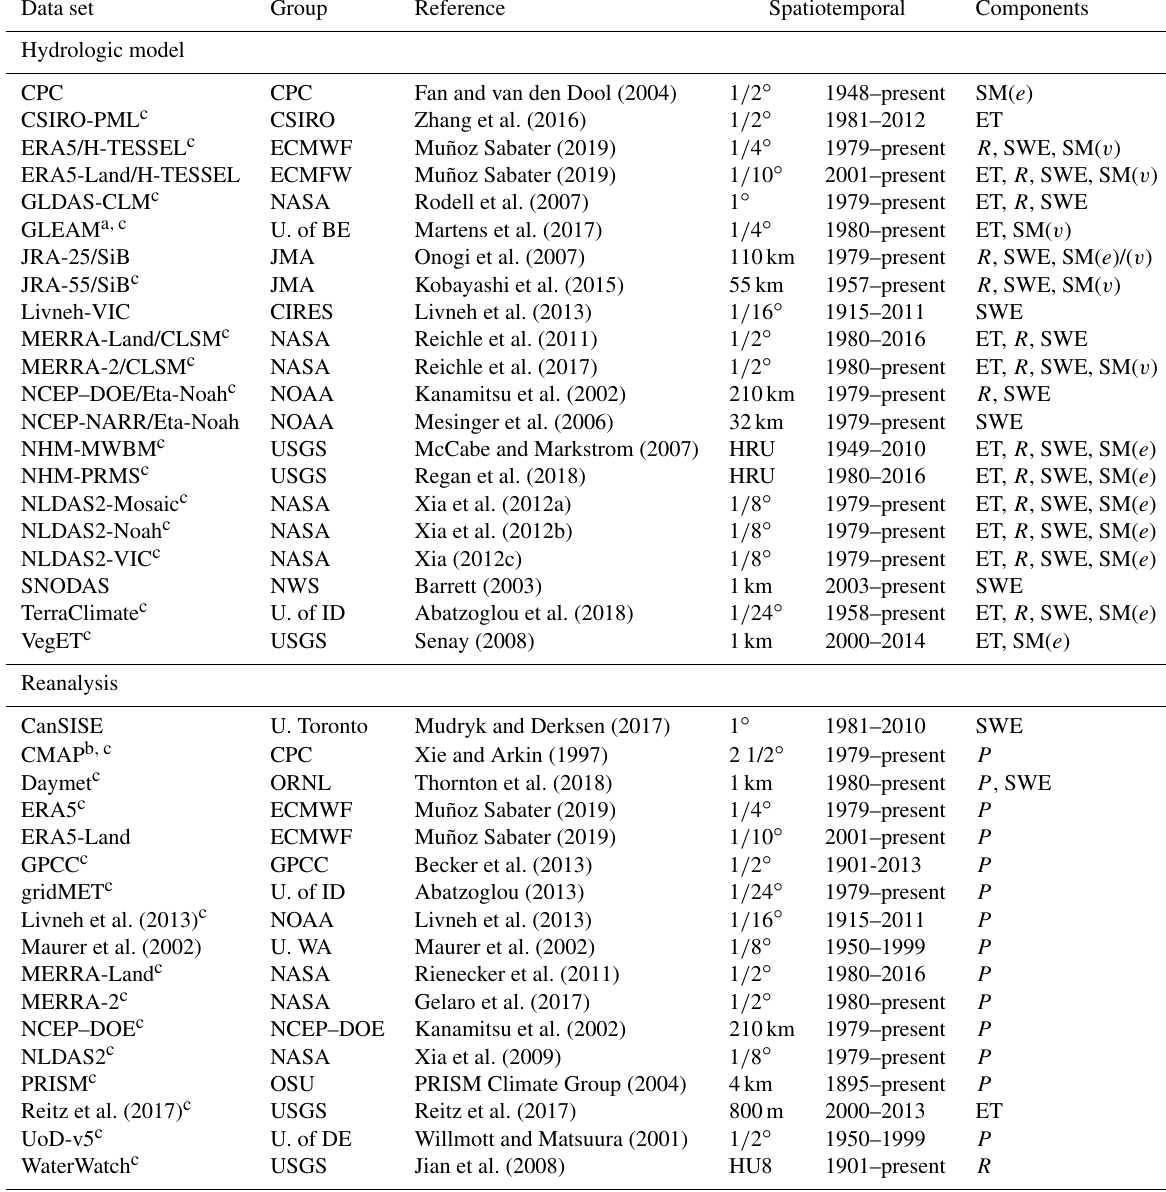
Table 1. Summary of data sets used in this research, including assigned data category, abbreviated name, primary organization, literature reference, spatiotemporal resolution, and sourced hydrologic components. The reader is referred to Appendix A for definitions of abbrevi- ated model names, descriptions, and further references. Components are precipitation ( P ), evapotranspiration (ET), runoff ( R ), snow water equivalent (SWE), and soil moisture in equivalent water depth and volumetric water content (SM( e ) and SM( v ), respectively). Hydrologic models NMH-MWBM and NMH-PRMS are based on a delineated (i.e., non-gridded), topographically derived spatial framework composed on hydrologic response units (HRUs). The reanalysis product WaterWatch is generated at hydrologic units (HUs) 2–8. The finest-resolution product, HU8, is used in this